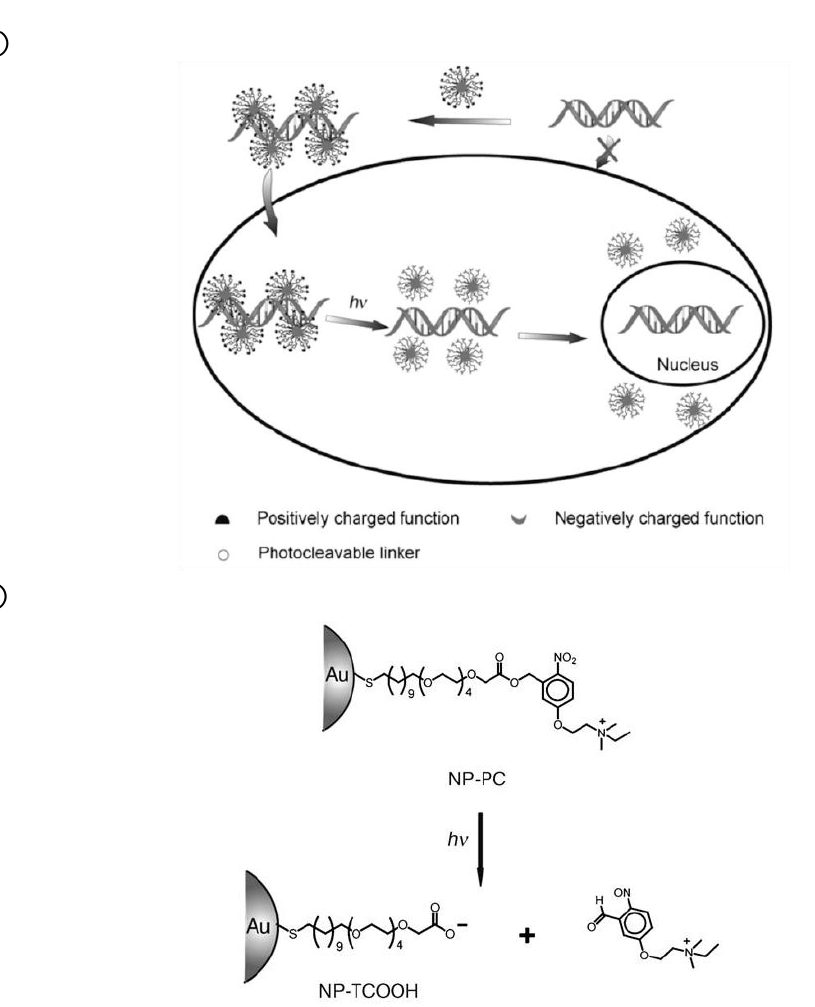
Figure 8. (A) Schematic illustration of the release of DNA from the AuNPs modified with photocleable linker; (B) The change of electrostatic properties on AuNPs surface before and after UV illumination. Reproduced with permission from [106] ® 2006, Wiley-VCH Verlag GmbH & Co. KGaA.